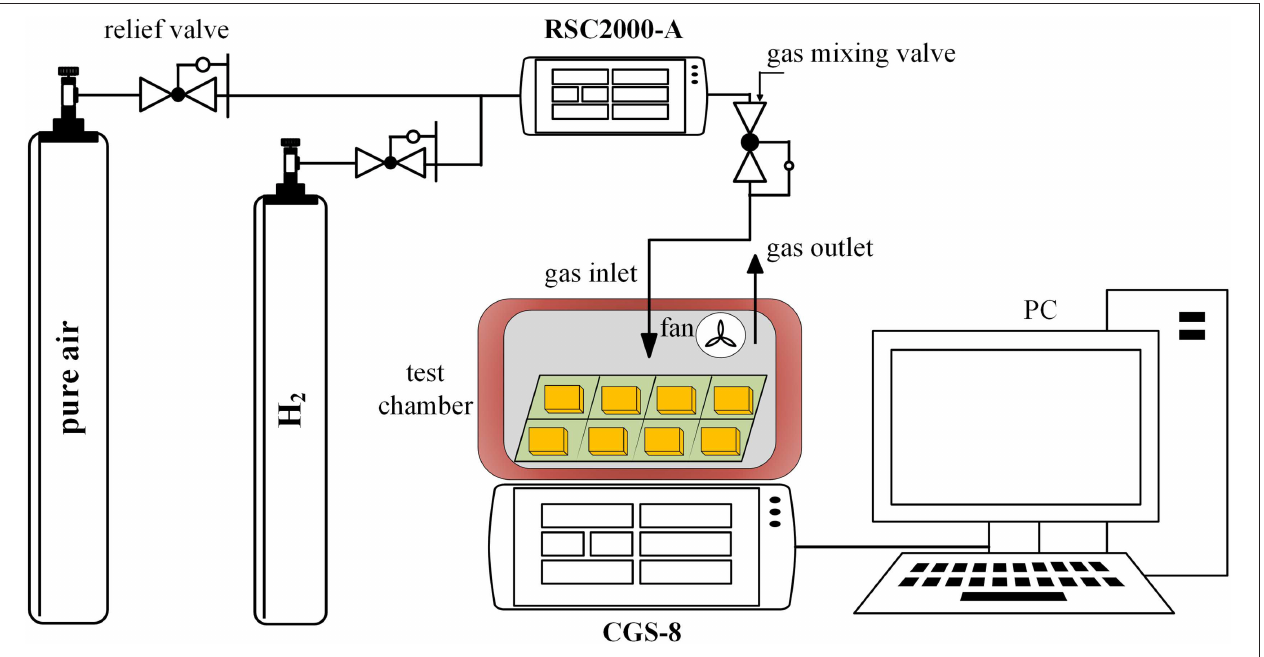
FIGURE 4 | The experimental platform.